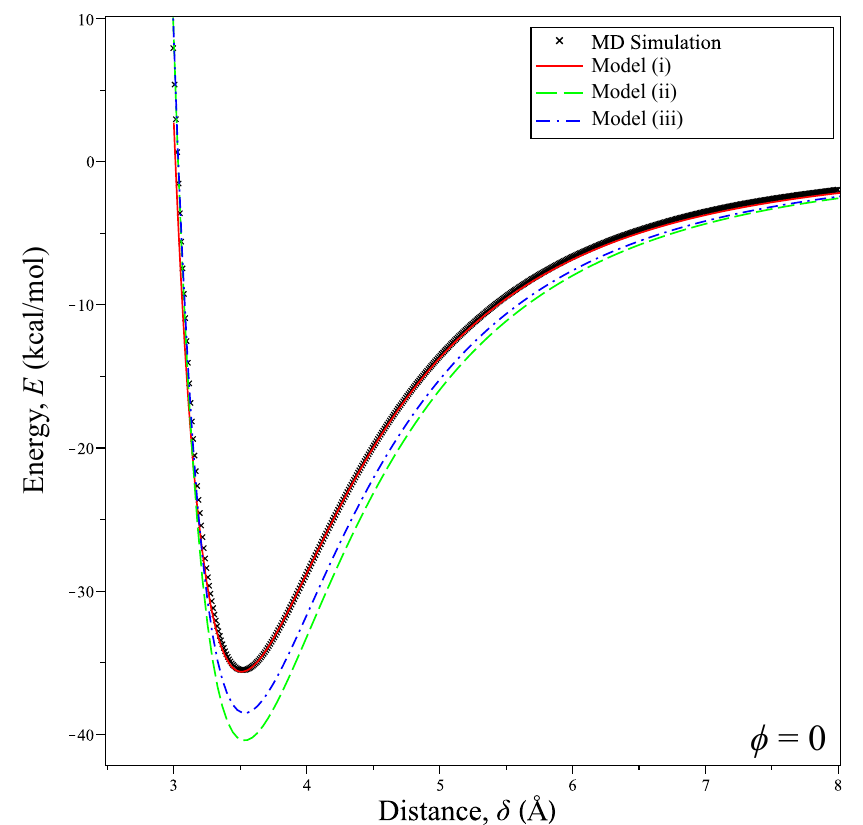
Figure 3. Calculated potential energy between coronene and graphene at a tilt angle φ = 0 compared with MD simulation.